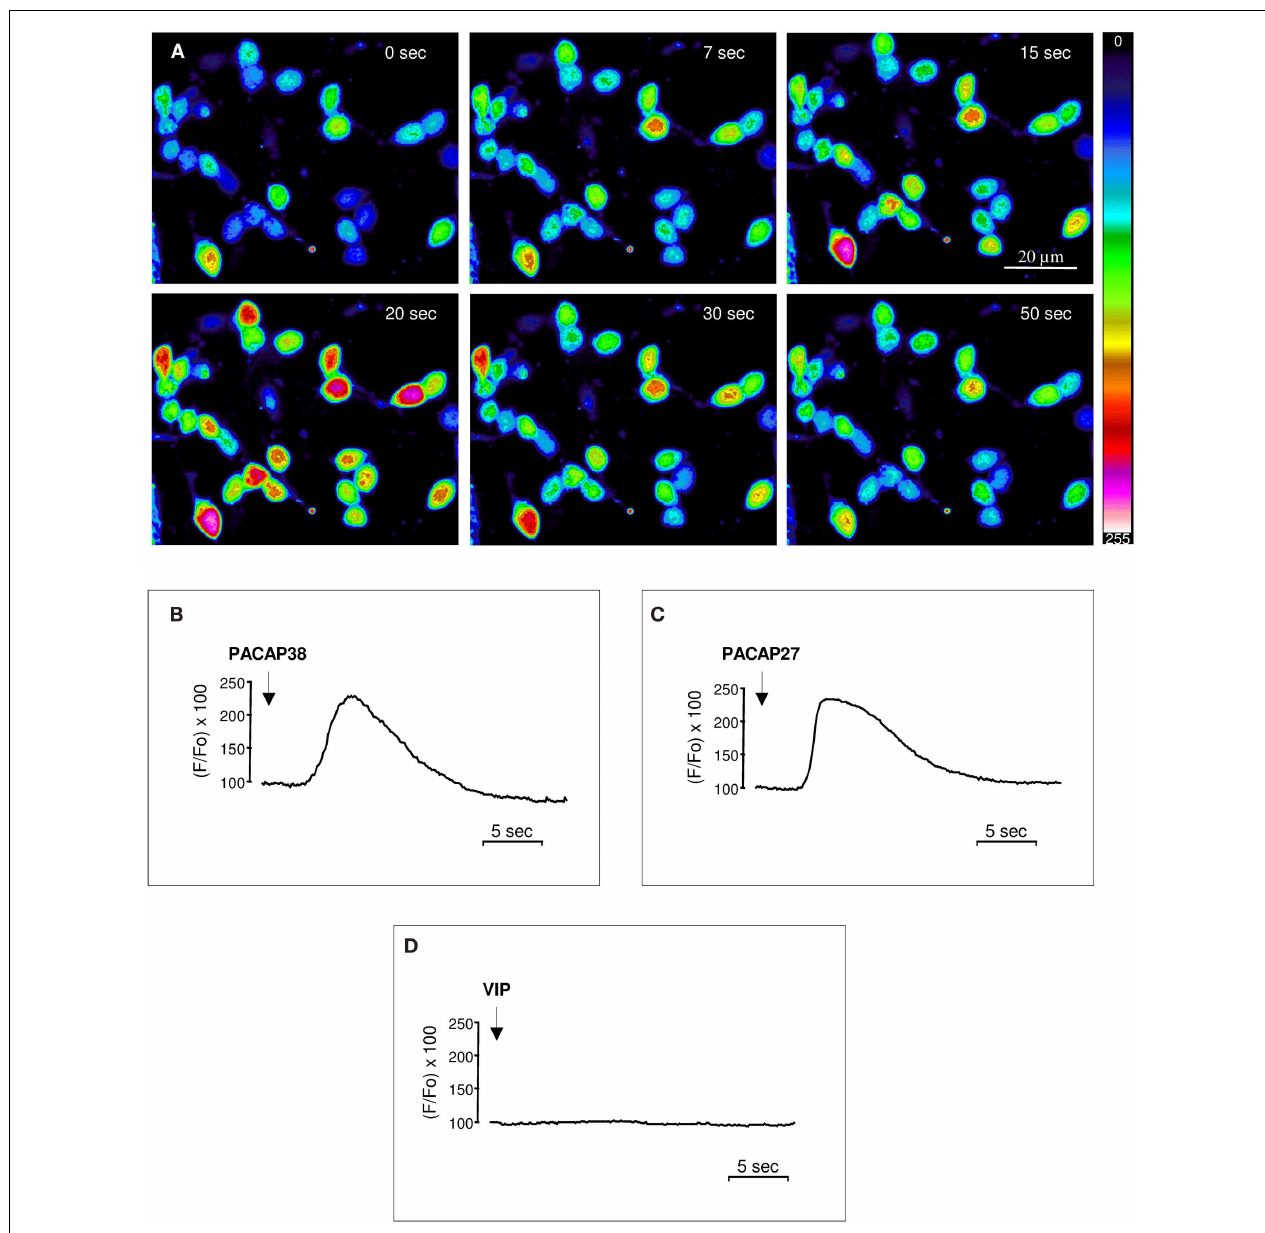
[Ca 2 + ] i changes expressed in arbitrary units. (B–D) Typical profiles illustrating the time-course of the variation of the fluorescence ratio evoked by a single application of 10 − 6 M PACAP38 (B) , PACAP27 (C) , orVIP (D) on [Ca 2 + ] i in cultured granule cells.The arrows indicate the onset of peptide